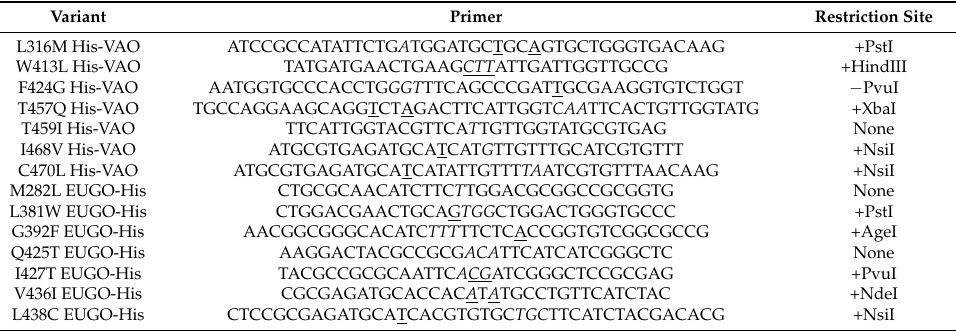
Table 5. List of primers used for site-directed mutagenesis in this study. Sites in italics indicate the position of the mutations introduced to achieve the amino acid substitution. Underlined sites indicate the position of mutations introduced to remove or introduce a restriction site to enable screening for the introduction of the correct mutations by restriction enzyme digestion (these are either the same mutations used for the amino acid substitution or silent mutations close to this site). The identity of the used restriction enzymes is given in the third column (+ indicates that a restriction site for this enzyme was introduced, − indicates that a restriction site for this enzyme was removed). His-VAO: His-tagged vanillyl alcohol oxidase, EUGO-His: His-tagged eugenol